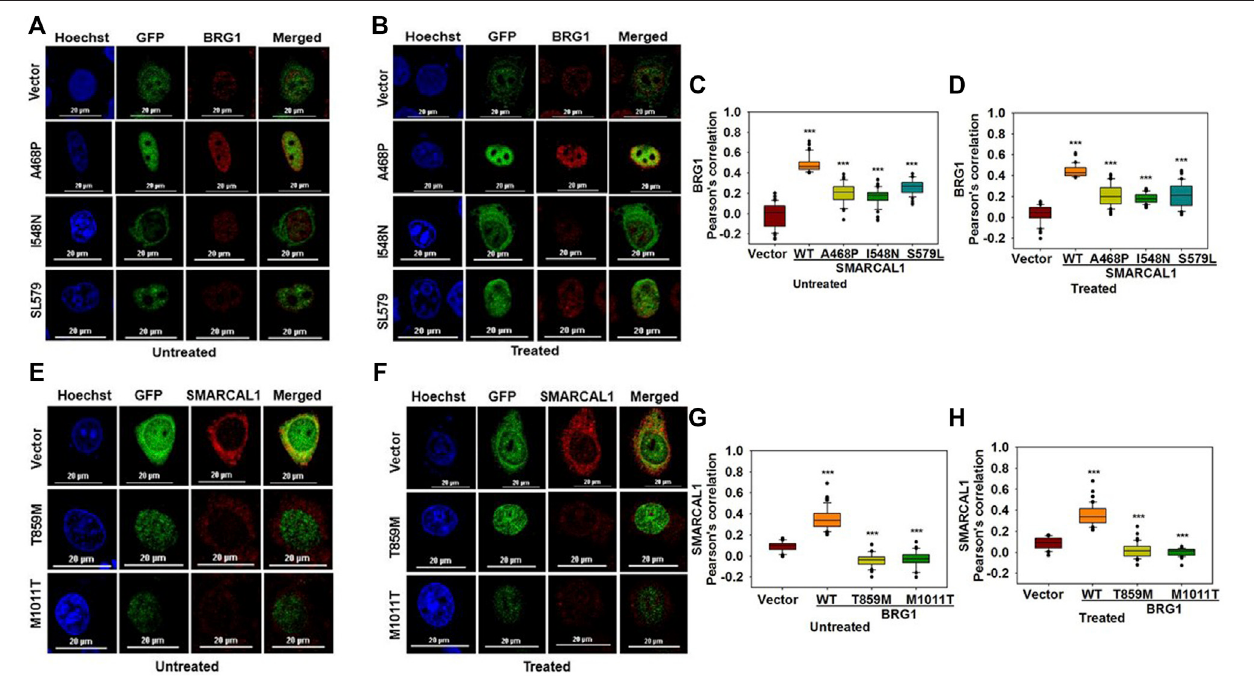
FIGURE 6 | Mutations associated with SIOD and CSS4 impairs the co-localization (A) . Co-localization of GFP-SMARCAL1-A468P, GFP-SMARCAL1-I548N, and GFP-SMARCAL1-S579L with BRG1 in the absence of doxorubicin treatment (B) . Co-localization of GFP-SMARCAL1-A468P, GFP-SMARCAL1-I548N, and GFP- SMARCAL1-S579L with BRG1 in the presence of 2 μ M doxorubicin treatment for 10 min (C) . Pearson ’ s coef fi cient for the interaction in the absence of doxorubicin treatment (D) . Pearson ’ s coef fi cient for the interaction in the presence of doxorubicin treatment (E) . Co-localization of GFP-BRG1-T859M and GFP-BRG1- M1011TwithSMARCAL1intheabsenceofdoxorubicintreatment (F) .Co-localizationofGFP-BRG1-T859MandGFP-BRG1-M1011TwithSMARCAL1inthepresence ofdoxorubicintreatment (G) .Pearson ’ scoef fi cientfortheinteractionintheabsenceofdoxorubicintreatment (H) Pearson ’ scoef fi cientfortheinteractioninthepresence ofdoxorubicintreatment.Inalltheseexperiments,HeLacellsweretreatedwith2 μ Mdoxorubicinfor10 minandn ≥ 60cellsforGFP-SMARCAL1-A468PandBRG1,n ≥ 50cellsforGFP-SMARCAL1-I548NandBRG1,andn ≥ 90cellsforGFP-SMARCAL1-S579LandBRG1wereanalyzed.Starindicatessigni fi cancewith* p -value < 0.05, ** p -value < 0.005, *** p value < 0.0001. The wild-type data used in the analysis has been shown in Figure 2 . The scale in the images is 20 μ m.